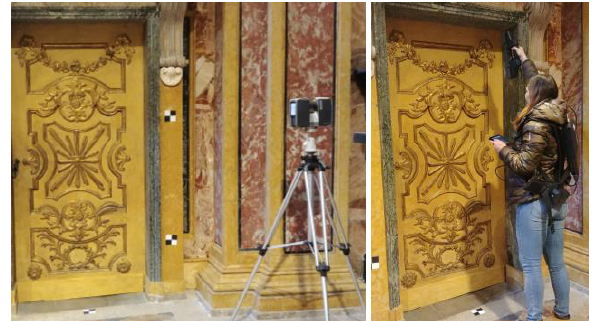
Figure 7a and b. TLS and F6 SMART data acquisition.